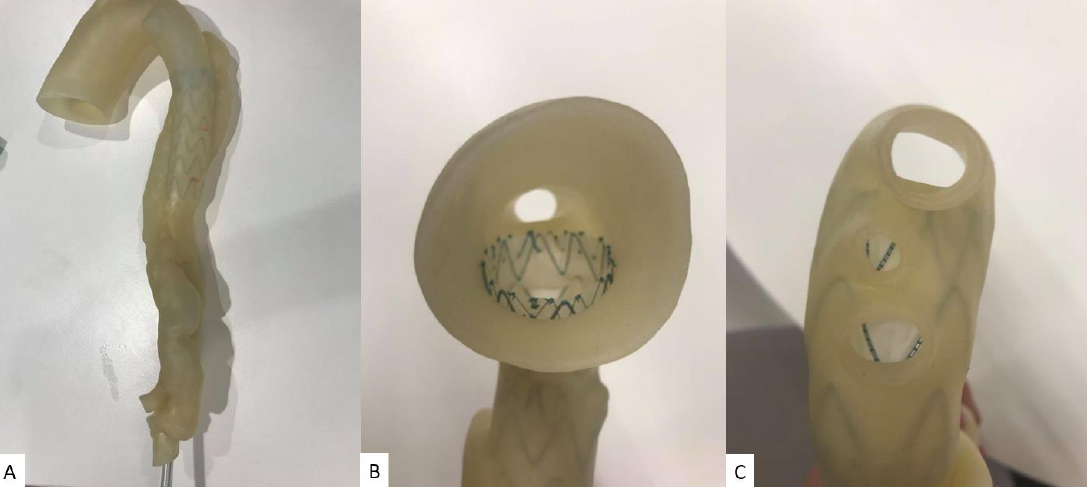
Figure 14. Stent graft deployed in 3D-printed model. The aortic model was printed with soft and elastic Visijet CE-NT A30 (USD 600) with properties similar to normal aorta. ( A ): Deployed stent graft visible through model wall. ( B ): Axial view from proximal aortic arch. ( C ): Caudal view down aortic arch vessels. Reprinted with permission under the open access from Wu et al. [34].